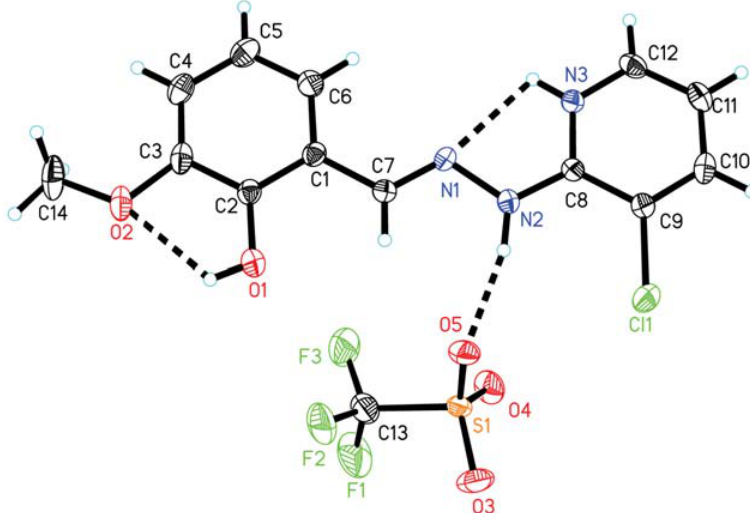
Figure 1. Crystal structure of (HL)CF